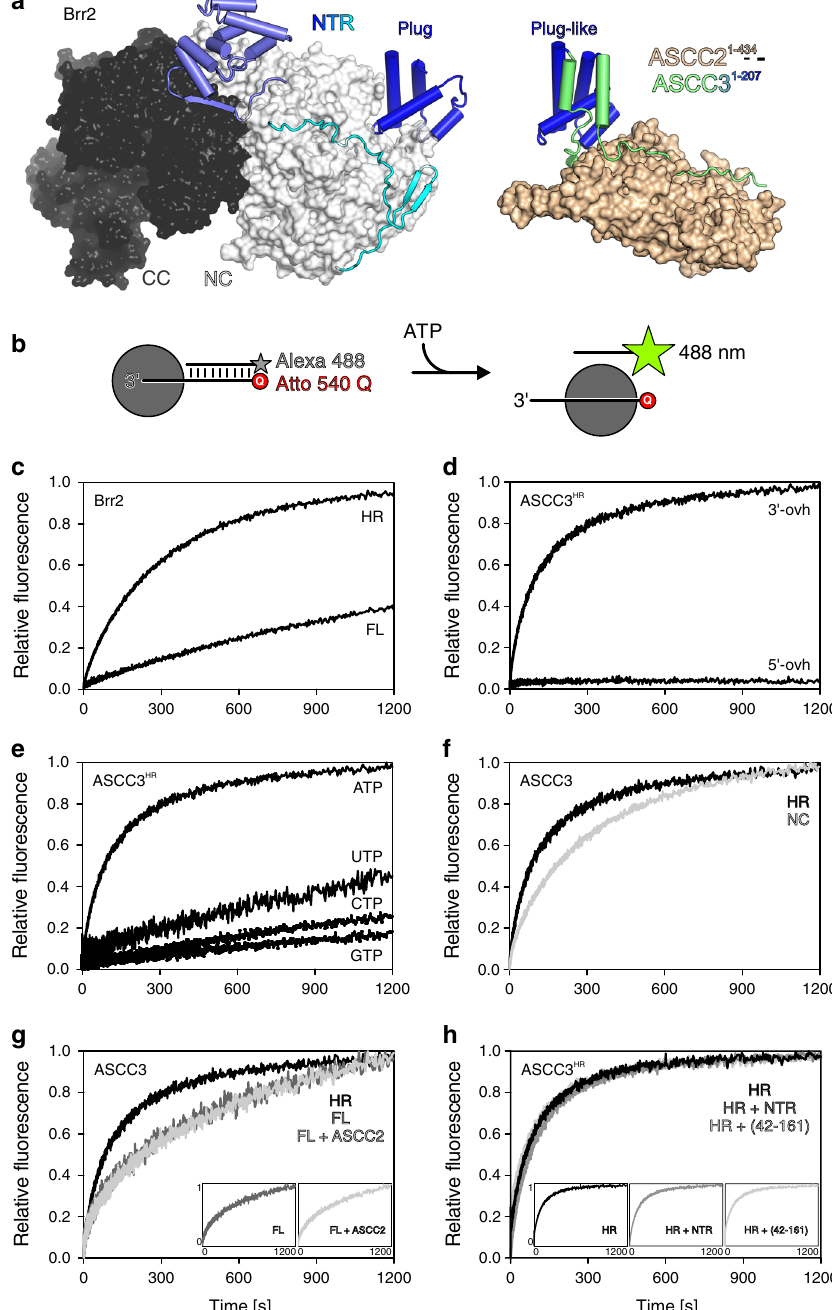
Fig. 5 Unwinding assays. a Comparison of the structure of full-length yeast Brr2 (left) and the present ASCC2 1 – 434 -ASCC3 1 – 207 complex (right) after superposition of the plug/plug-like domains (blue). Human Brr2 in the U4/U6 (cid:129) U5 tri-snRNP or in the pre-catalytic spliceosome exhibits a plug domain very similar to yeast Brr2 blocking RNA access 42,43 (PDB IDs 3JCR, 6QW6, 6QX9). NC, N-terminal cassette; CC, C-terminal helicase cassette. b Experimental setup for stopped- fl ow/ fl uorescence-based unwinding assays. Gray sphere, helicase; star symbol, fl uorophore (Alexa 488); Q, quencher (Atto 540 Q). c Stopped- fl ow/ fl uorescence-based assays monitoring unwinding of a 3 ’ -overhang RNA by Brr2 FL or Brr2 HR , showing that auto-inhibition, which has been documented for Brr2 using gel-based unwinding assays 33 , can be readily detected using the present experimental setup. d Stopped- fl ow/ fl uorescence-based assays monitoring unwinding of DNA bearing a 3 ’ -overhang (3 ’ -ovh), and lack of unwinding of a 5 ’ -overhang (5 ’ -ovh) DNA by ASCC3 HR upon addition of ATP. e Nucleotide preference of ASCC3 HR in unwinding a 3 ’ -overhang DNA. f Stopped- fl ow/ fl uorescence-based assays monitoring unwinding of 3 ’ -overhang DNA by ASCC3 NC compared to ASCC3 HR using ATP. g Stopped- fl ow/ fl uorescence-based assays monitoring unwinding of a 3 ’ -overhang DNA by the indicated ASCC3 constructs in the absence or presence of ASCC2 using ATP. Insets, side-by-side presentation of the largely overlapping curves. h Stopped- fl ow/ fl uorescence-based assays monitoring unwinding of a 3 ’ -overhang DNA by ASCC3 HR alone or in the presence of ASCC3 NTR or ASCC3 42 – 161 using ATP. Insets, side-by-side presentation of the largely overlapping curves. FL/HR/NC/NTR/(42 – 161), ASCC3 variants as de fi ned in the